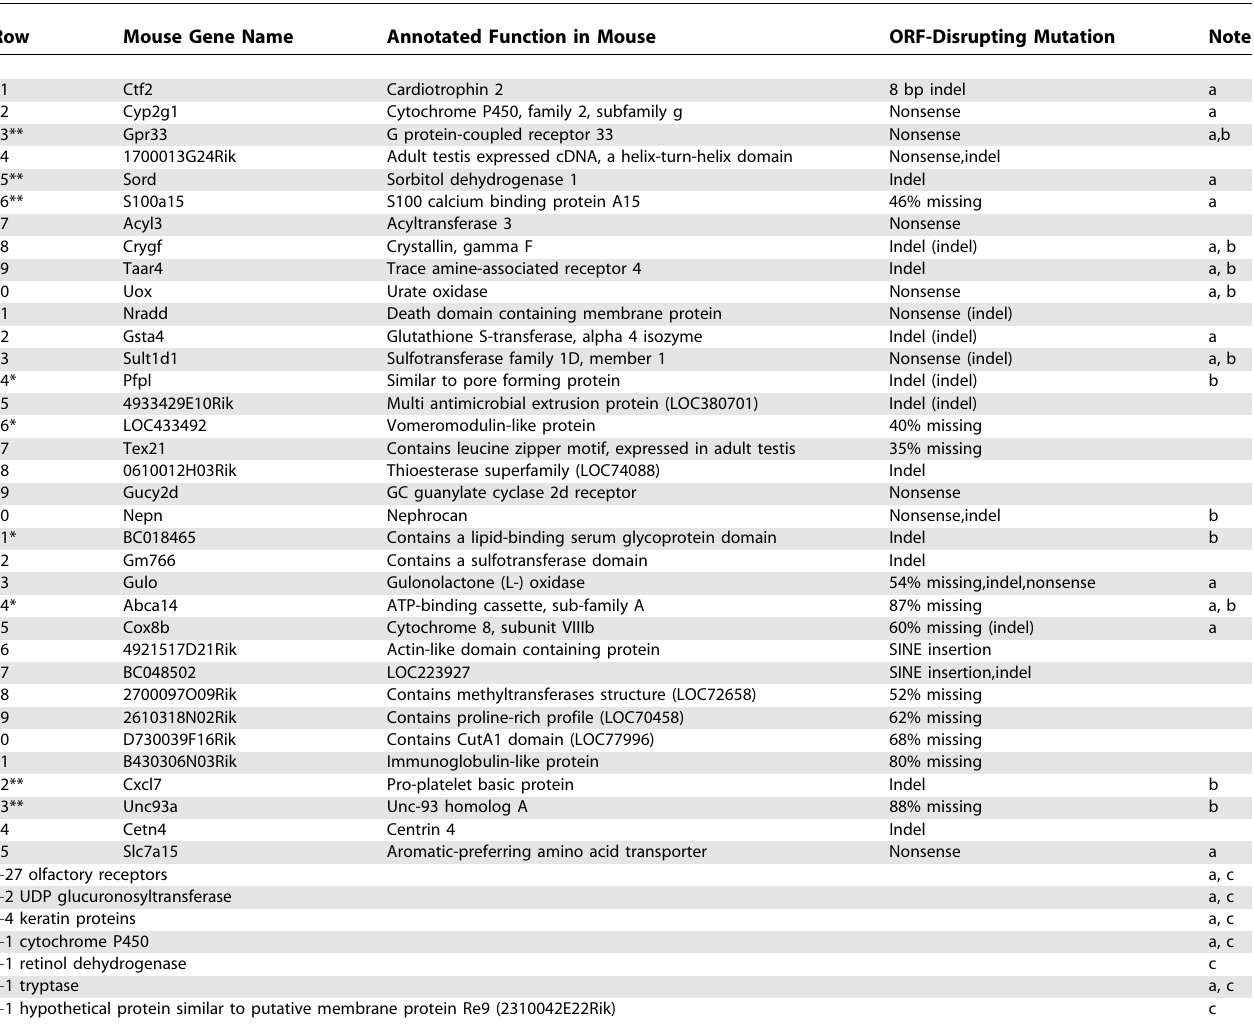
Table 1. Gene Losses in the Human Lineage since the Common Ancestor of Euarchontoglires Row Mouse Gene